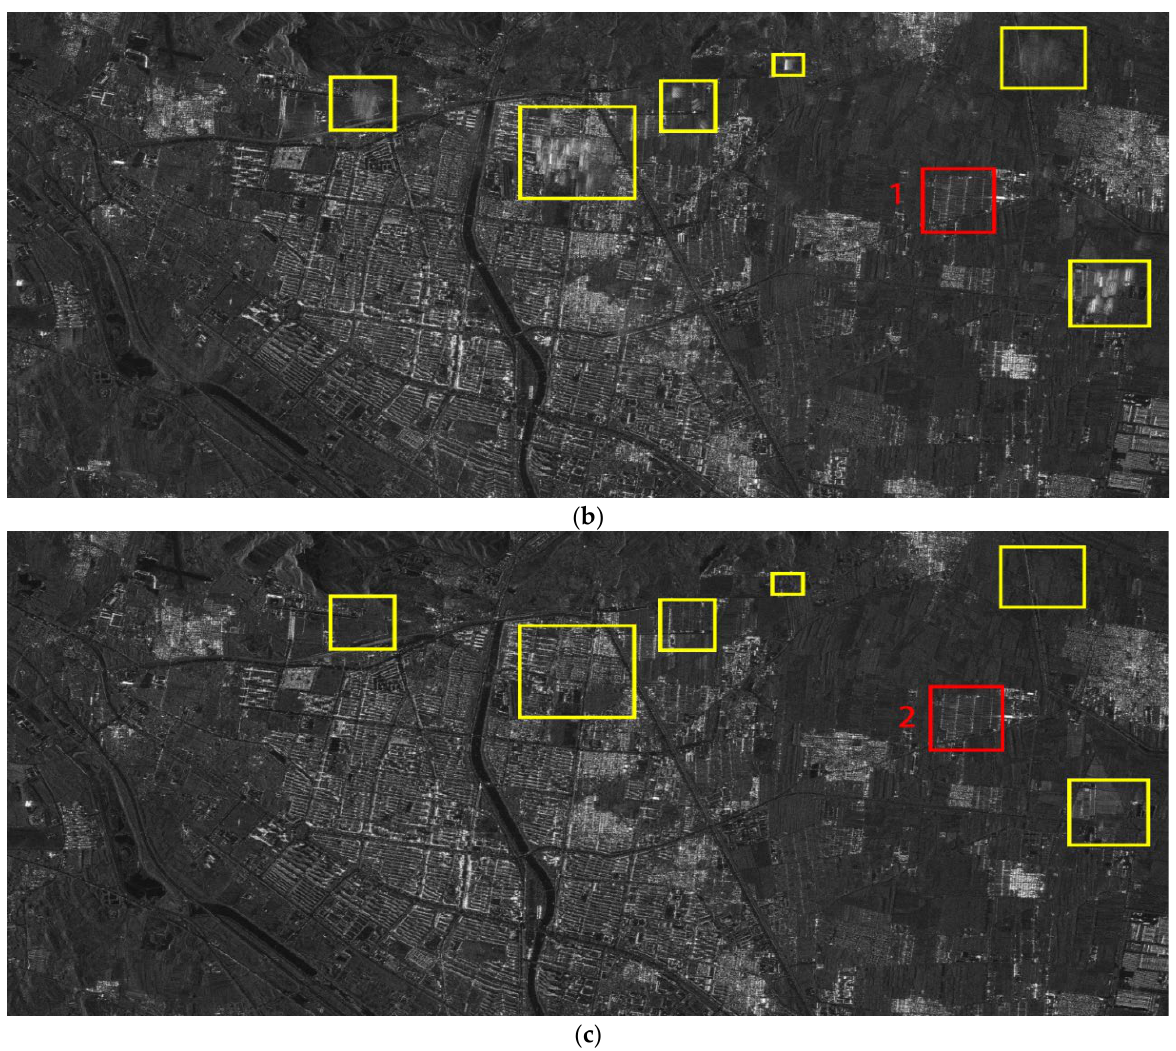
Figure 11. The imaging results of GF-3 data in SDC mode. ( a ) is the imaging result based on ESRM without Doppler centroid compensation; ( b ) is the imaging result based on ESRM after preprocessing and reconstruction; ( c ) The imaging result using the scheme proposed in this paper.